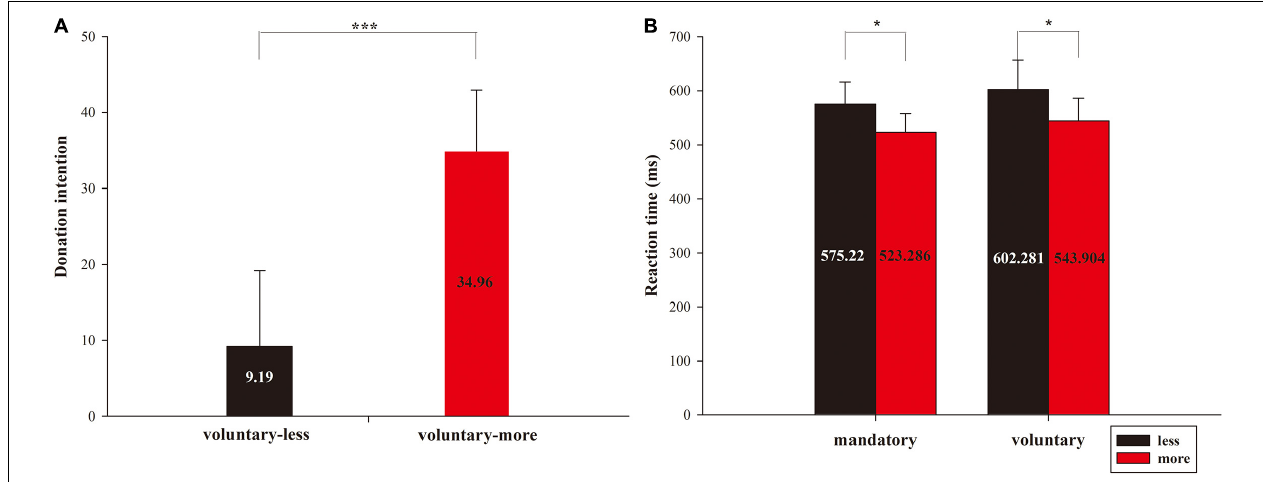
FIGURE 3 | Behavioral results of donation intention and reaction time. (A) The donation intentions of the subjects under voluntary conditions. (B) The reaction time of the subjects for the four conditions of 2 donation contexts (mandatory vs. voluntary) × 2 amounts (less vs. more). * p < 0.05, *** p <